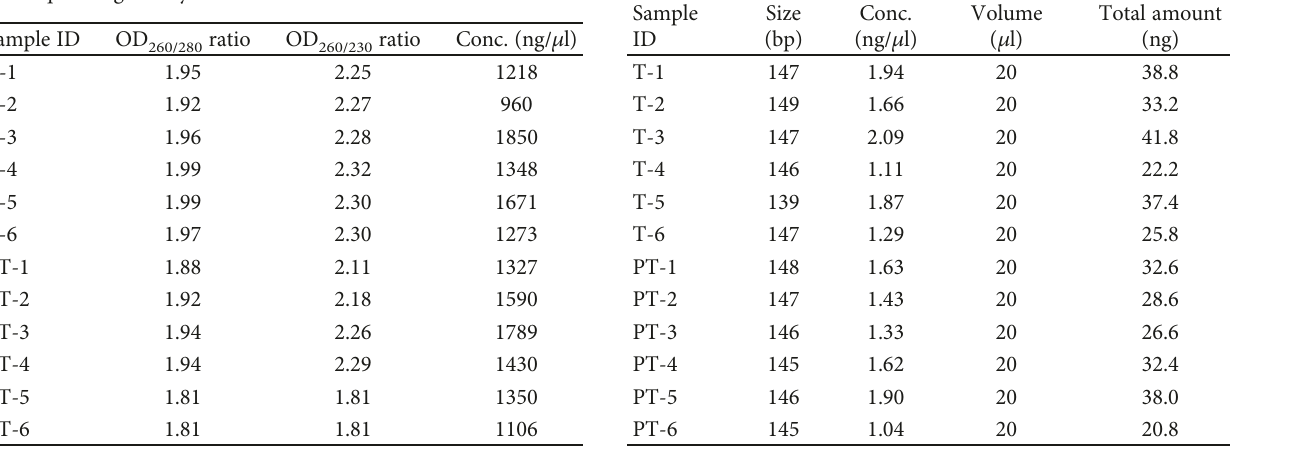
Table 1: Quality control of RNA samples for the construction of miR sequencing library.